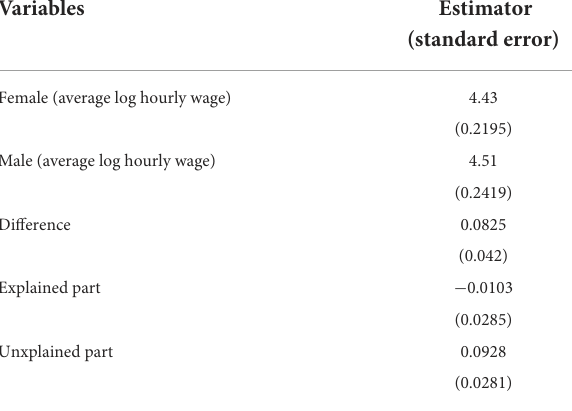
TABLE 3 Blinder-Oaxaca decomposition of the gender wage